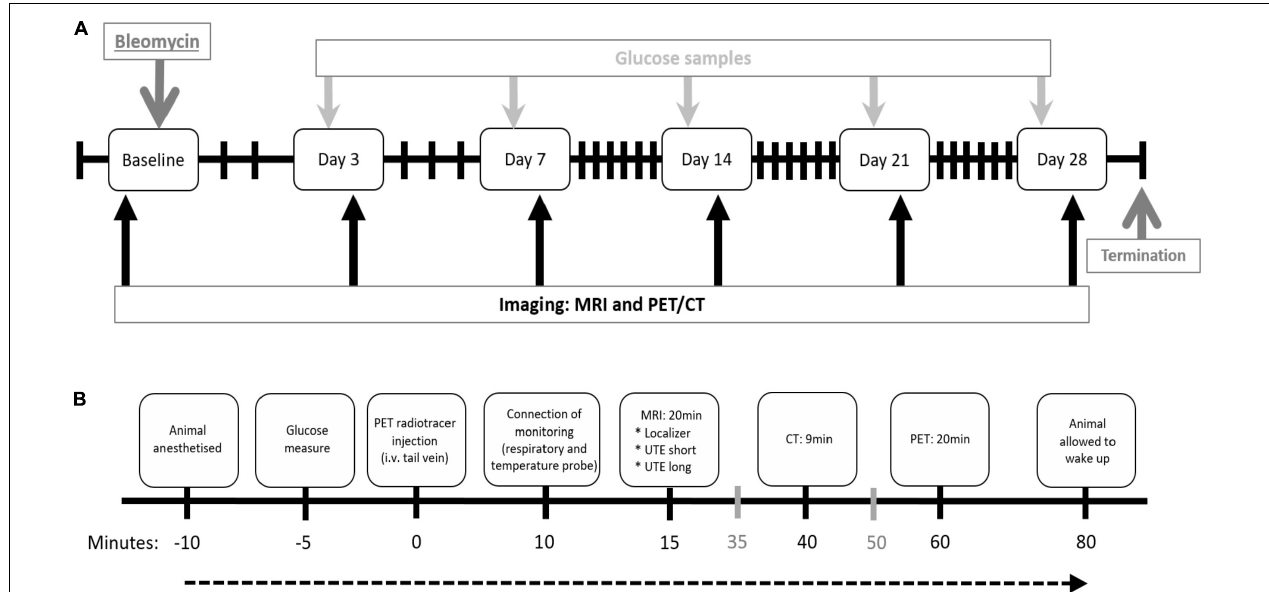
FIGURE 1 | Study layout and imaging workflow chart. (A) Study layout of the DIILD model with bleomycin-induced lung injury in Sprague–Dawley male rats. Imaging was performed at baseline (scan 1) before the intratracheal (i.t.) administration of bleomycin. Control rats received saline as i.t. challenge. Imaging sessions occurred at day 0, 3, 7, 14, 21, and 28 post challenge. Before every scan session, blood glucose was measured. Termination occurred at day 28, after the final imaging session. (B) Workflow for each imaging session. Events expressed in gray (35 and 50 min after injection) indicate when the following rat is prepared while the scan of the previous rat is being performed. i.v. =